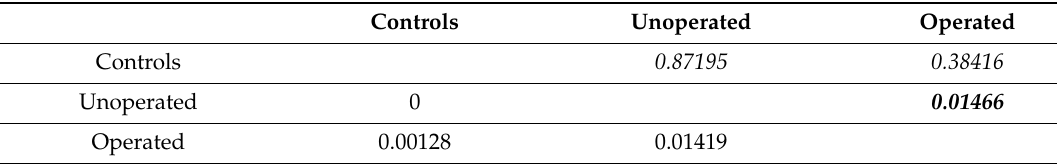
Table 5. Genetic di ff erentiation factor.